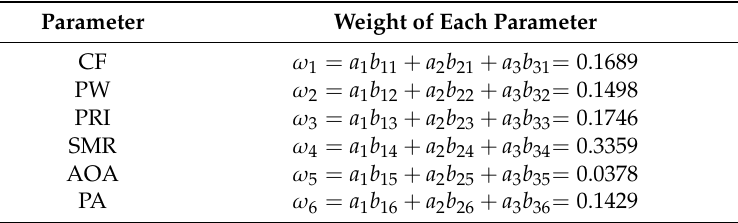
Table 3. Weights of each parameter in the scheme